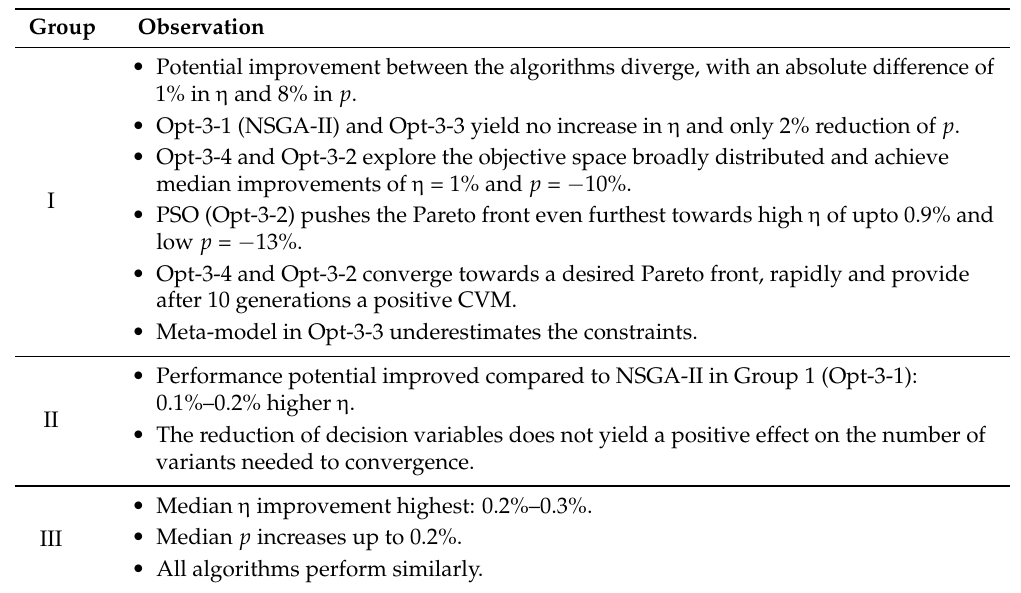
Table 11. Potential improvement and convergence observations of Opt-3.